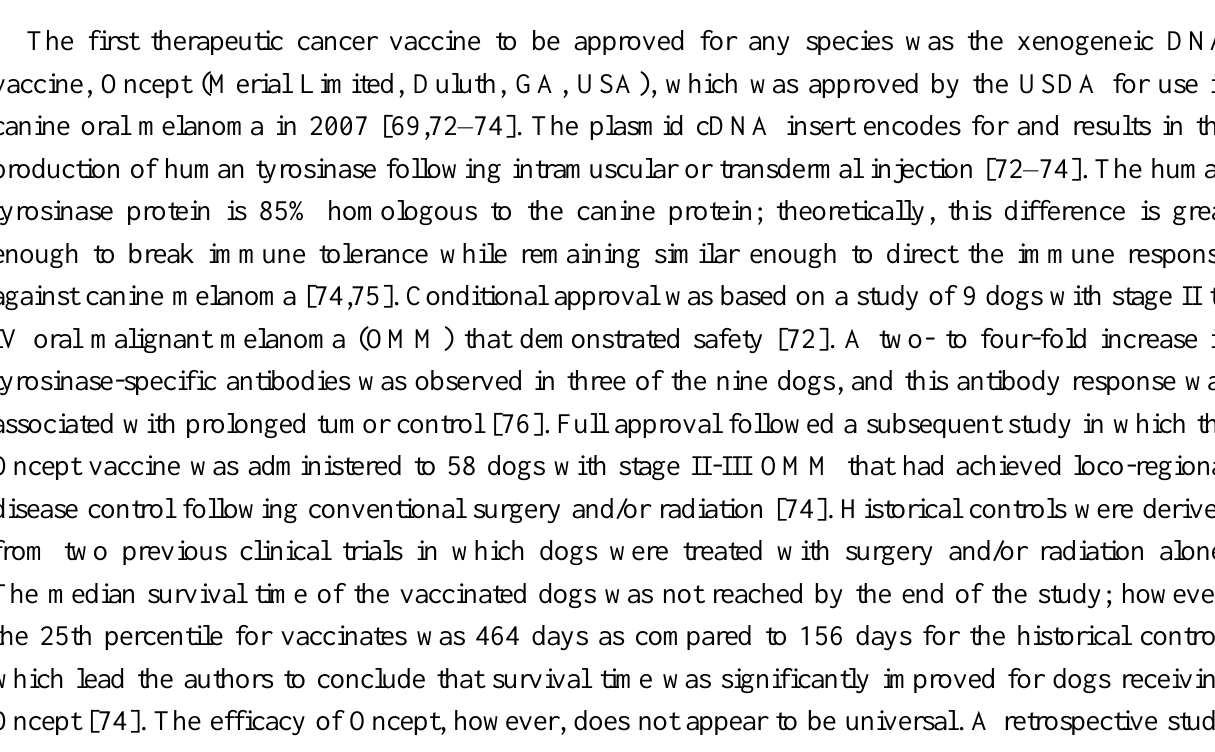
Figure 3. Vaccination strategies and challenges. Vaccines utilize a variety of strategies to activate the immune system against tumor associated antigens (TAAs), including tumor cell lysates or peptide antigens, dendritic cells (DCs) activated with TAAs, and DNA plasmids designed to produce TAAs. The TAAs must then be presented by functional antigen presenting cells to T cells capable of recognizing the TAA. Once activated, T cells must traffic to the tumor and induce tumor cell death. T cell tolerance to TAAs, dysfunctional antigen presentation, T-cell exhaustion induced by checkpoint inhibitors (such as PD-1), and immunosuppressive cells in the tumor microenvironment may all result in suppression of the immune response and variable patient responses to